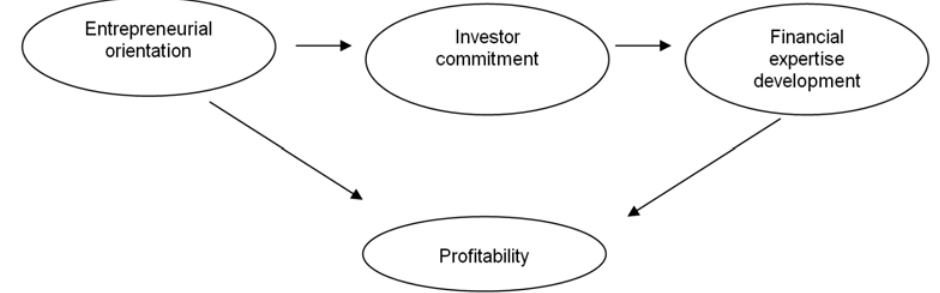
Fig. 1. The hypothesized relationships between the constructs